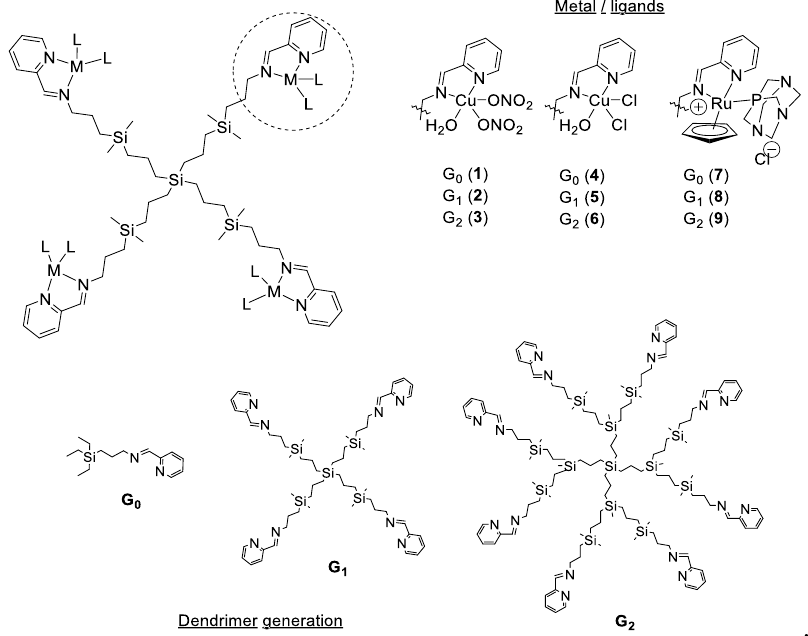
Figure 1. Chemical representation of the tested Schiff-base carbosilane metallodendrimers, highlighting the structural parameters studied.